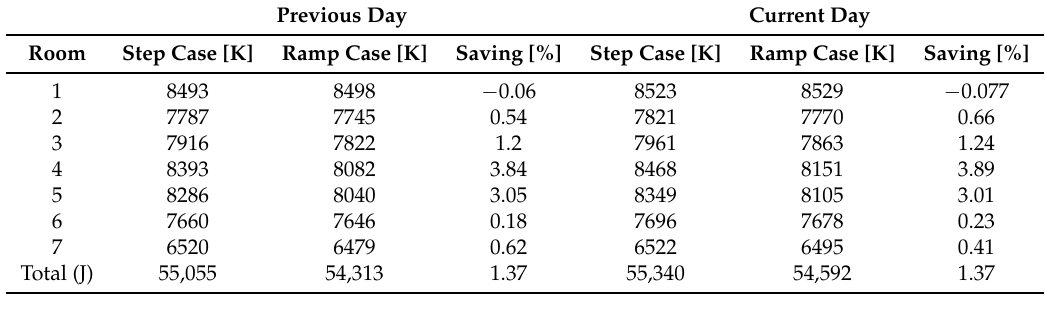
Table 7. Performance index value (4) for fan-coil units in both step and ramp case evaluated by applying the optimal set-point signals with the TRNSYS model using weather conditions of the previous days (4 December, i.e., those used by the genetic algorithm) and of the current day (5 December).